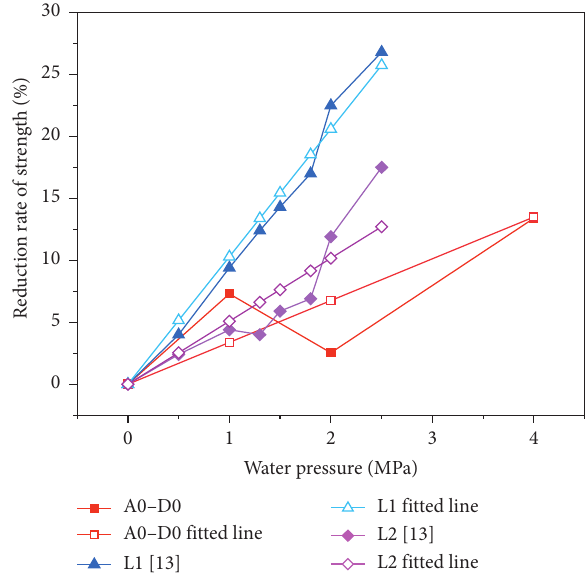
Figure 5: Calculated values of the static reduction rate of strength versus tested